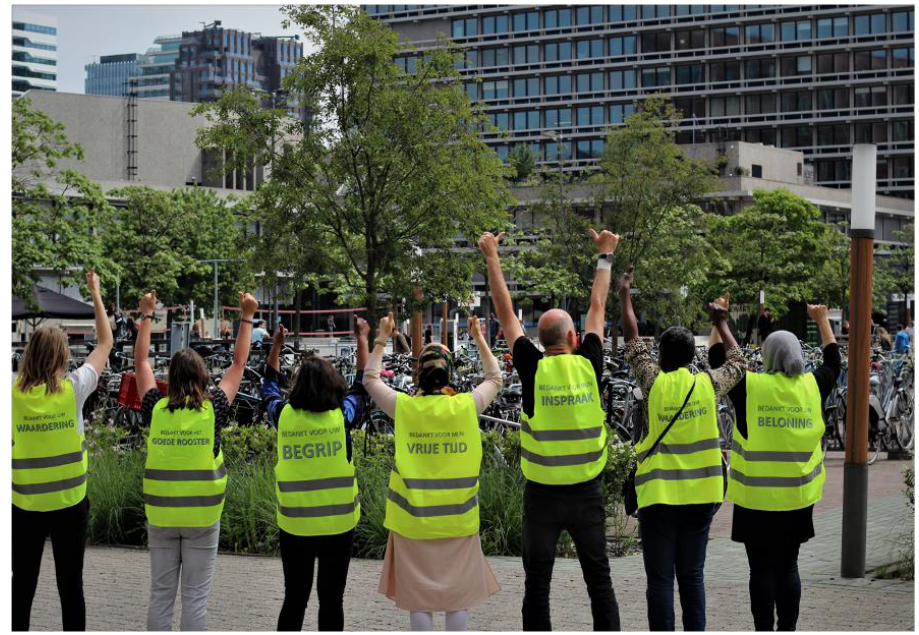
Figure 5. Picture of community researchers with yellow vests.